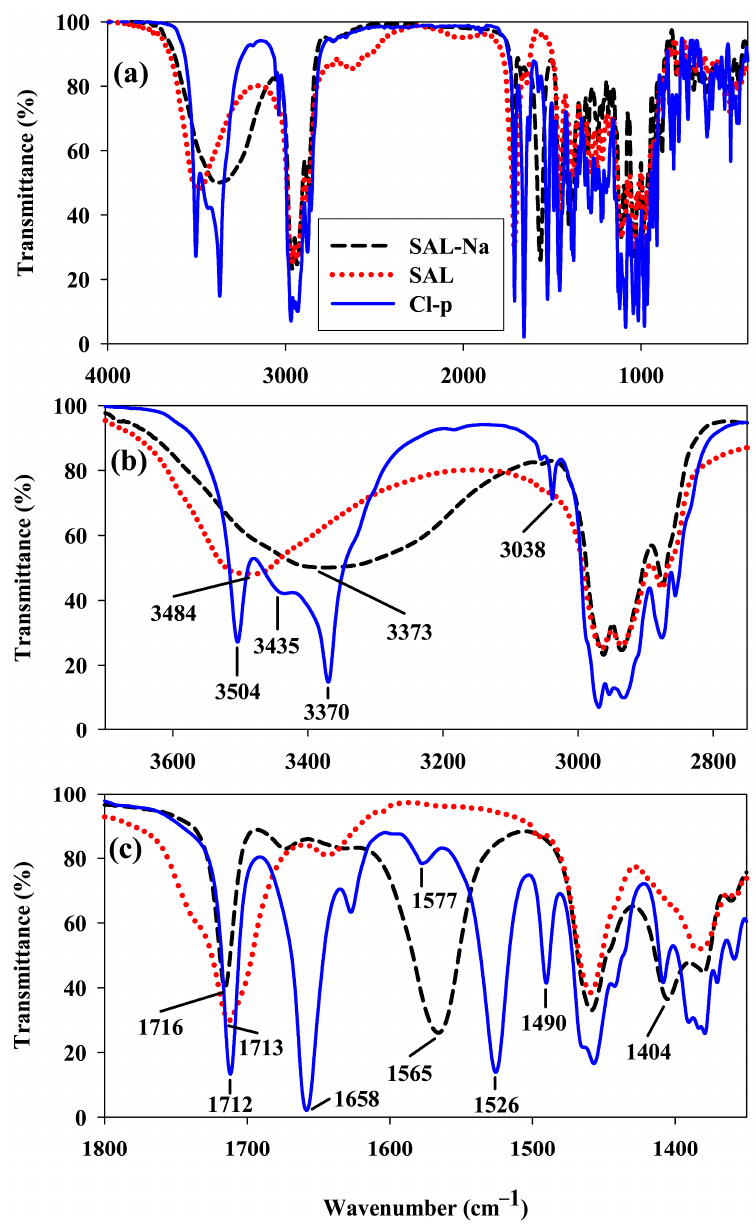
Figure 2. FT-IR spectra of salinomycin sodium salt ( SAL-Na ), salinomycin ( SAL ) and p -chlorobenzyl amide of salinomycin ( Cl- p ) made for KBr tablet; ( a ) 4000–400 cm − 1